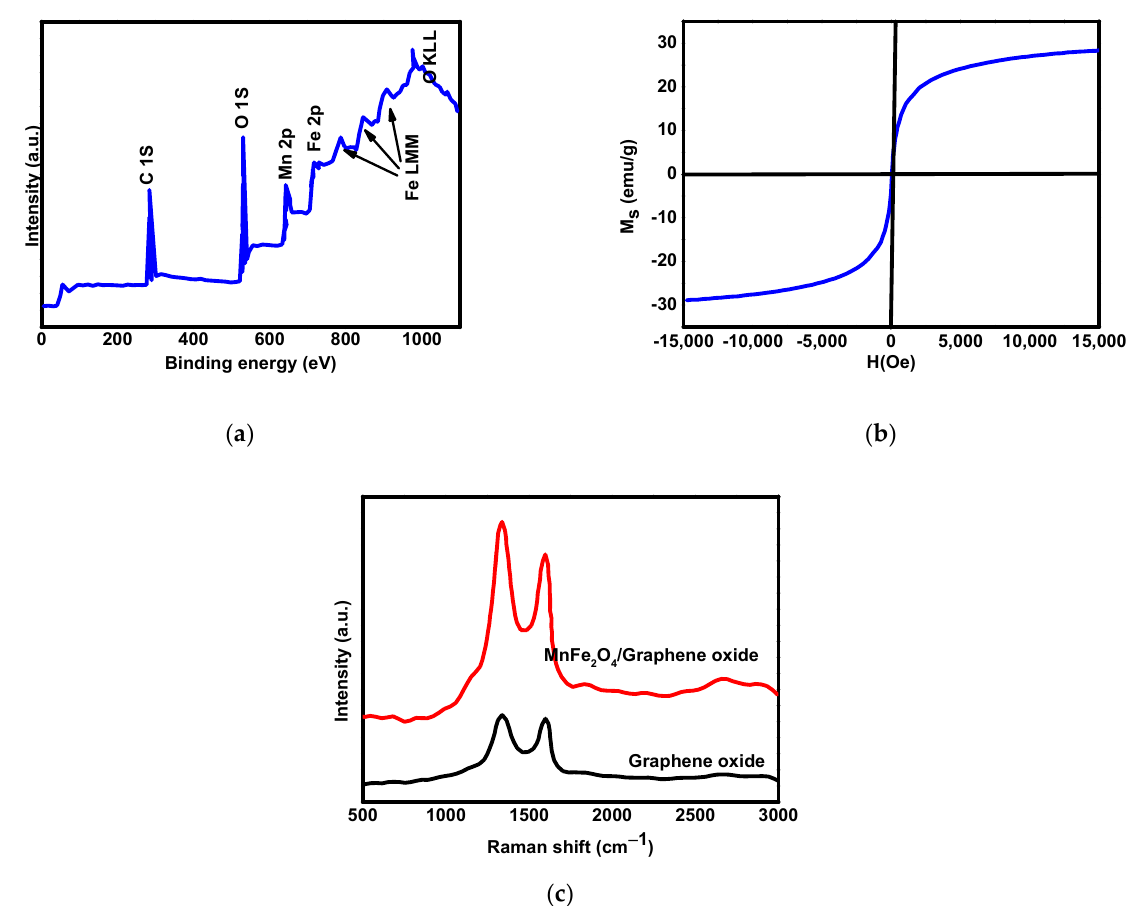
Figure 3. Wide scan XPS ( a ), room temperature magnetization curve ( b ), and Raman spectra ( c ) of MnFe 2 O 4 /GO nanocom- posite.